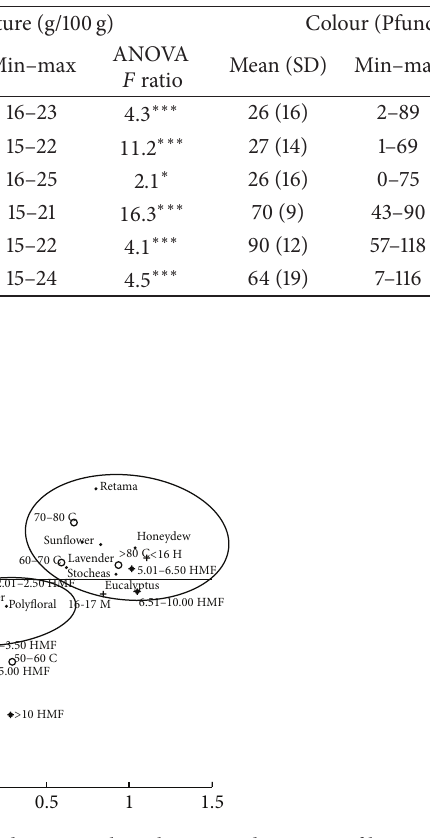
Table 2: Influence of the beekeeper on the physicochemical parameters (HMF, moisture, and colour) and different types of honey. ANOVA results ( 𝐹 -ratio and significant differences) for the factor: beekeeper.